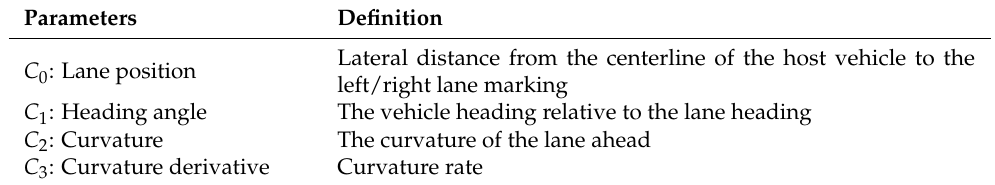
Table 1. Lane detection coefficients from MOBILEYE camera.